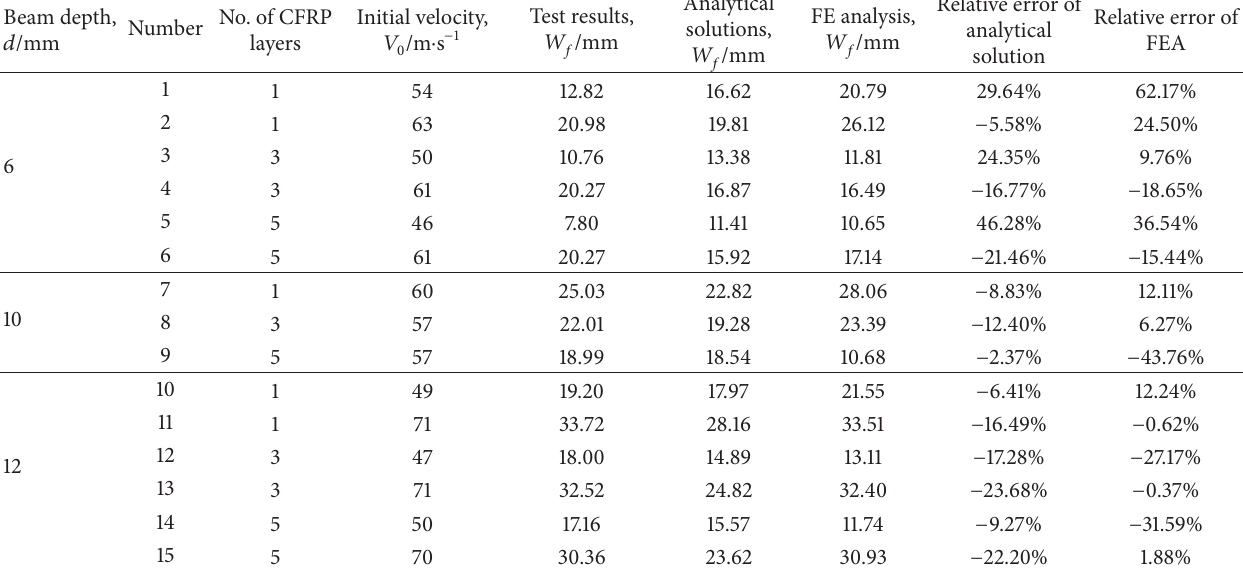
Table 2: Results of the three analysis methods for hybrid beams.